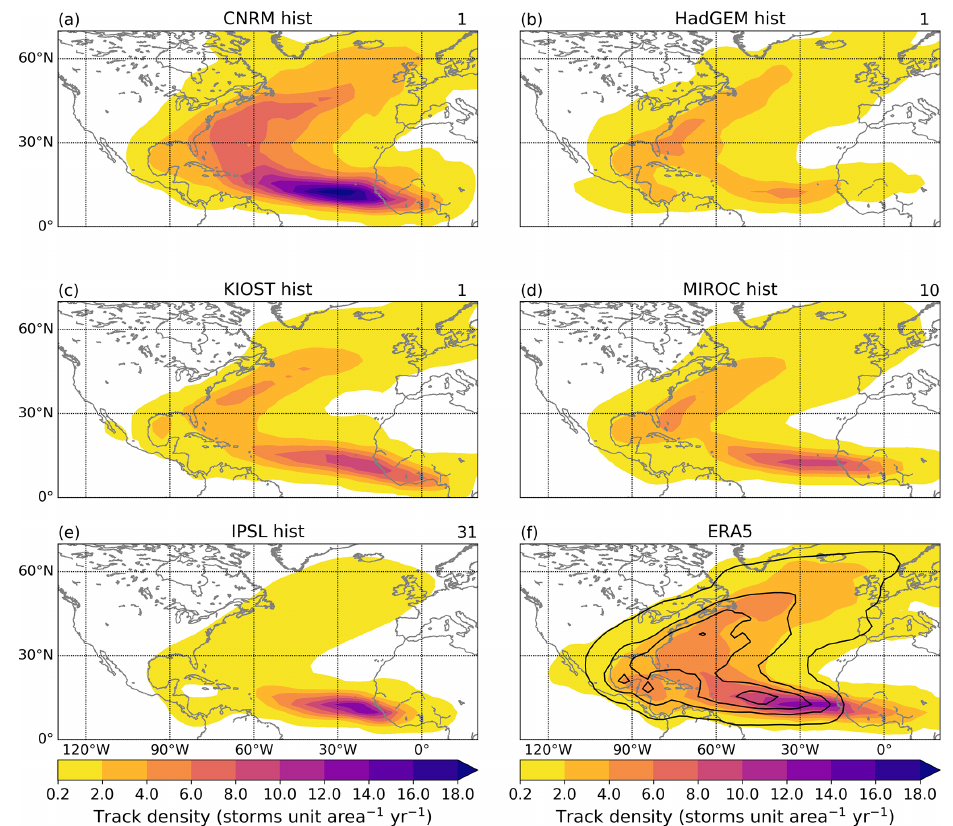
Figure 2. As in Fig. 1 but for track density. Densities less than 0.2 have been masked for clarity. Black contours in panel (f) represent 0.2, 2.0, 4.0, 6.0, and 8.0 storms per unit area per